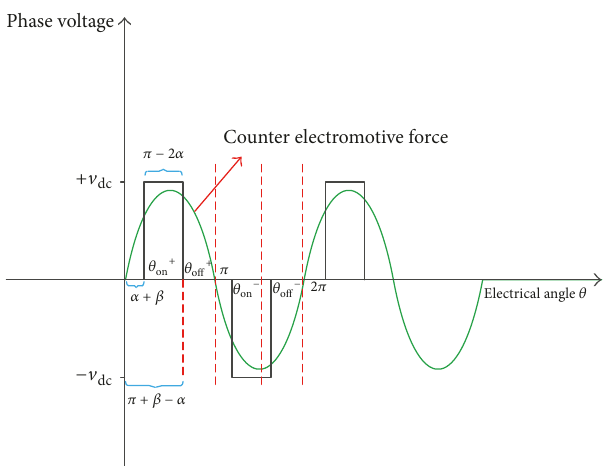
Figure 5: Quasi-square-wave voltage and counter electromotive force corresponding to the angle of the basic waveform and turn-off position.